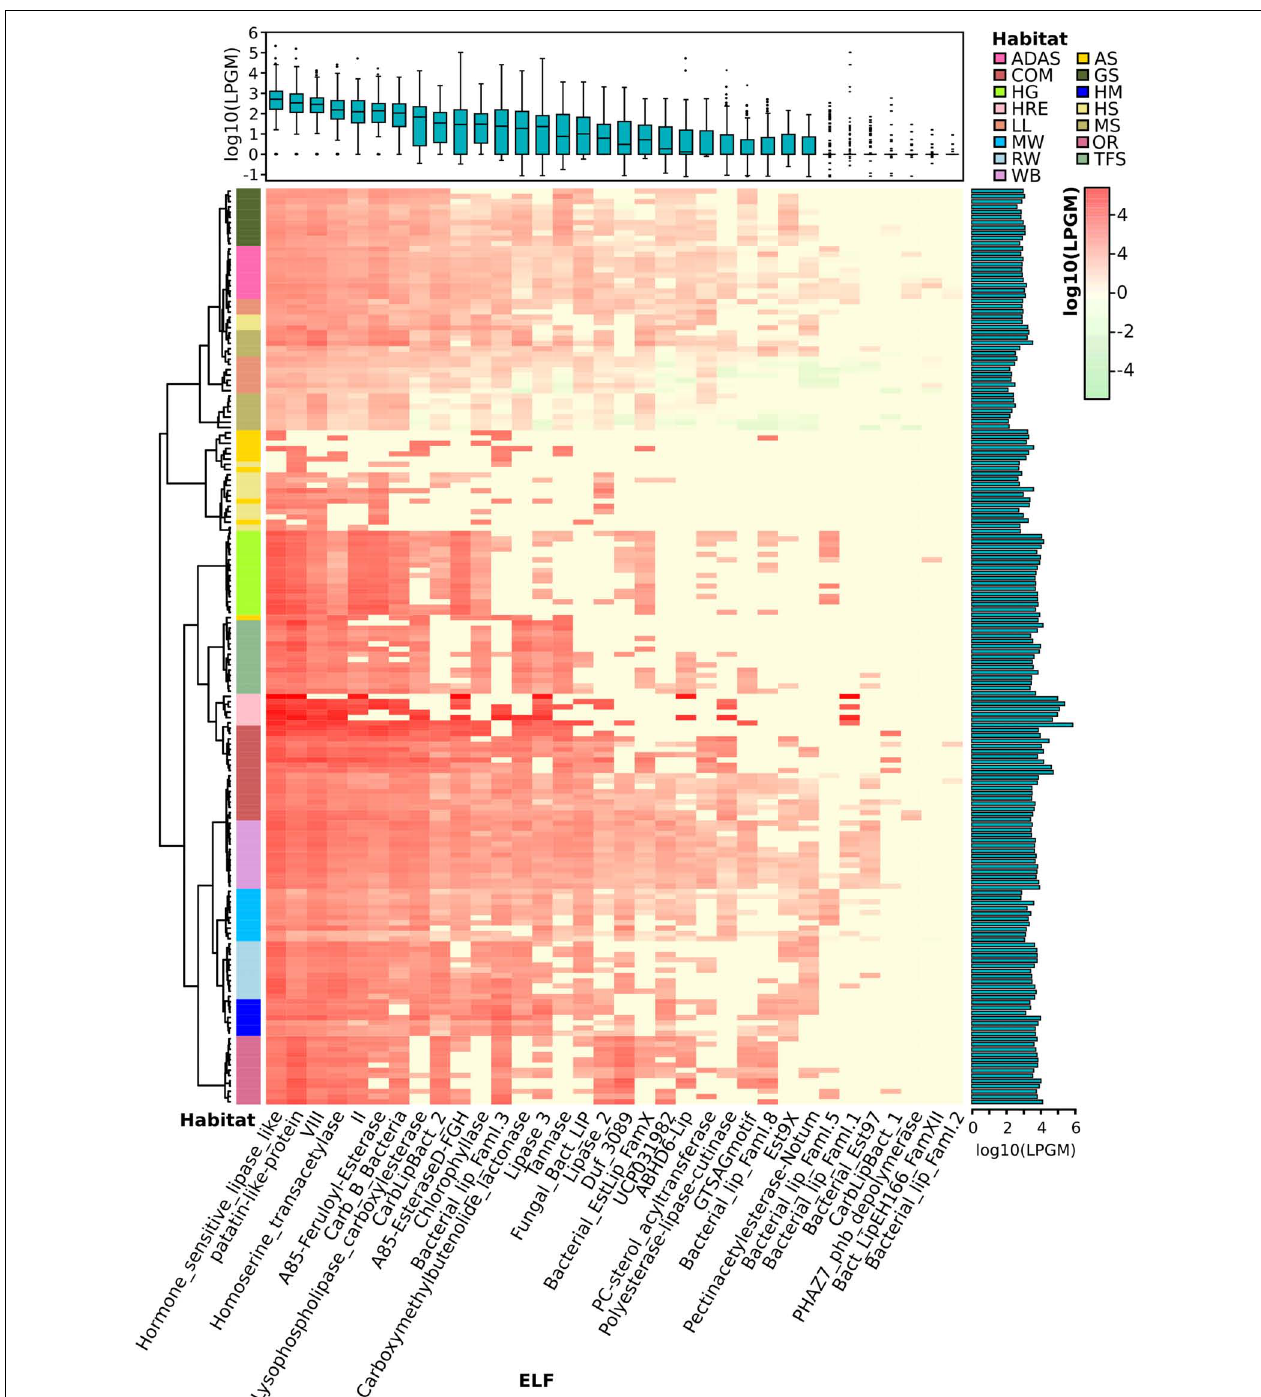
FIGURE 3 | Lipolytic family profile of assigned PLPs across samples. Hierarchical clustering analysis of the lipolytic family profile in each sample was performed using the Ward.D clustering method and Bray-Curtis distance matrices. LPGM values were log 10 transformed. The color intensity of the heat map (light green to red) indicates the change of LPGM values (low to high). The habitats are depicted by different colors. The lipolytic family profile in each sample was generally clustered by habitat (overall R value = 0.621, P < 0.001, ANOSIM test). The boxplot (top) represents the distribution of the assigned PLPs in each ELF across samples. Mean values ( n = 175 samples) are given. The bar plot (right) shows the total abundance of assigned PLPs by summing up the abundance in each family of each sample. Abbreviations of habitats: ADAS, anaerobic digestor active sludge; AS, agricultural soil; COM, compost; GS, grassland soil; HG, human gut; HM, hypersaline mat; HRE, hydrocarbon resource environment; HS, hot spring; LL, landfill leachate; MS, marine sediment; MW, marine water; OR, oil reservoir; RW, river water; TFS, tropical forest soil; WB, wastewater bioreactor; ELF, ESTHER lipolytic family.